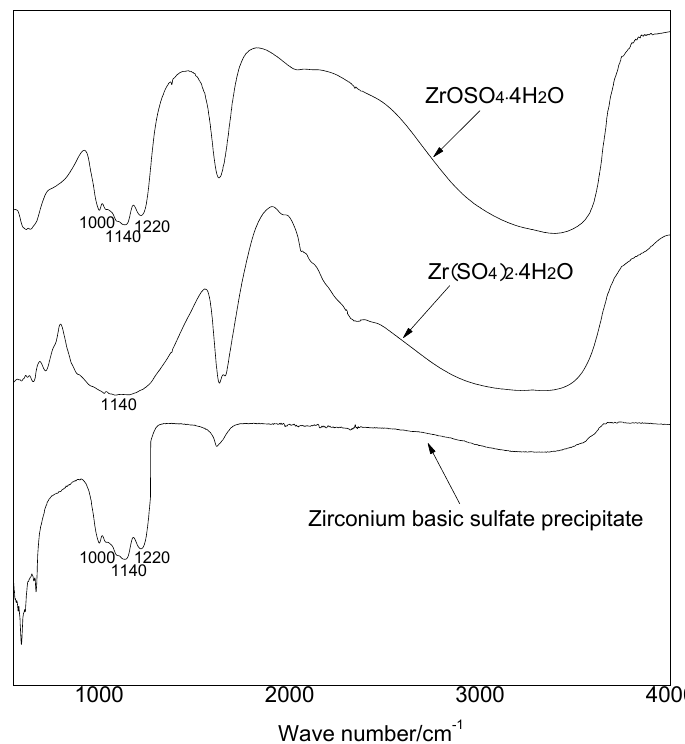
10 of 13 Figure 10. XRD pattern of the basic zirconium sulfate precipitate. Fourier-transform infrared spectroscopy analysis (FT-IR) was used to study the structure of basic zirconium sulfate precipitate further, and the FT-IR spectra of the resulting precipitate,